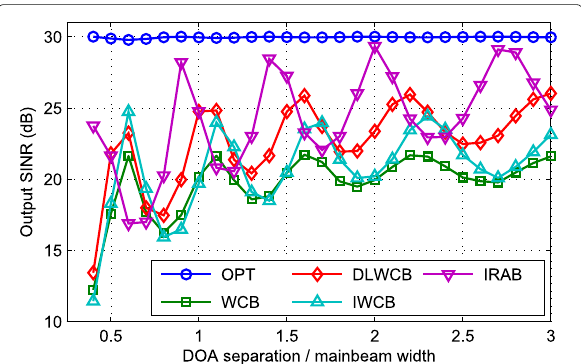
Fig. 13 SINR versus DOA separation: M=20, mainbeam width=12 ◦